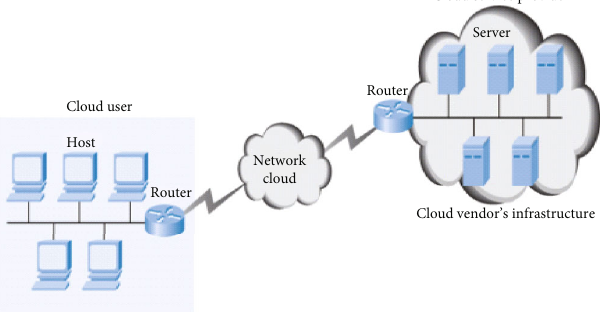
Figure 1: Sample cloud